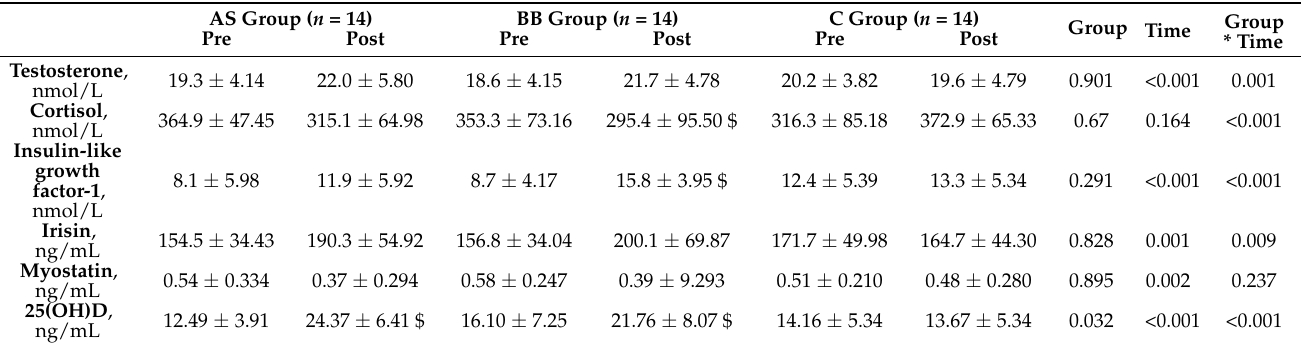
Figure 5. The violin plots of changes in the blood hormones in AS, BB, and C group after 6-week intervention. The thick solid lines indicate the mean value of changes of each group, and the thin solid lines indicate interquartile range. An asterisk (*) indicates the change of the index is significant ( p < 0.05). A pound sign (#) indicates the difference between groups is significant ( p < 0.05). Table 5. Changes in blood